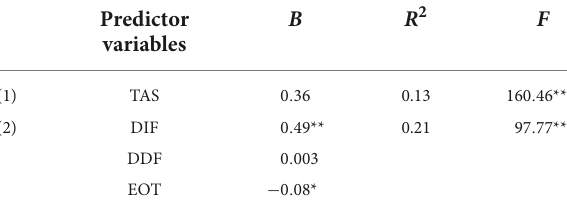
TABLE 4 Regression analysis for alexithymia and its constructs as predictors of cyberchondria ( N = 1,117).